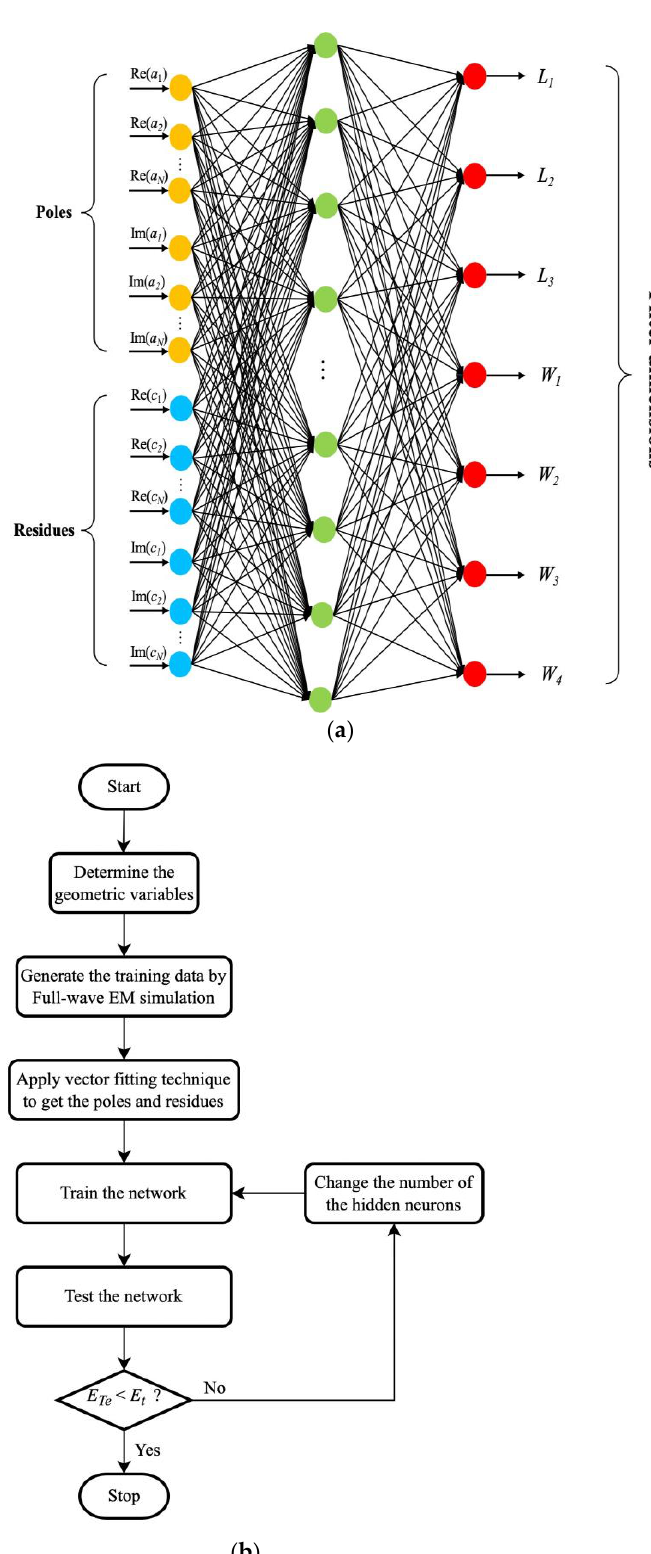
Figure 4. ( a ) The neural network structure of the proposed bandpass filter; ( b ) The flow chart of the overall process of the network model.